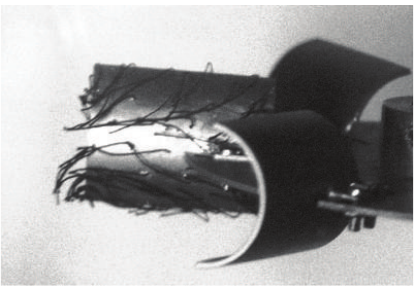
Figure 8: Telltales on CD-6 impeller blade.